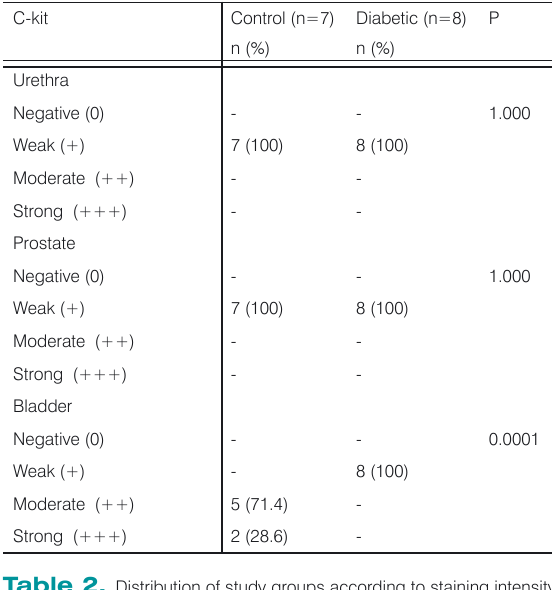
Table 1. Distribution of study groups according to staining intensity regarding c-kit positive interstitial cells present in the lower urinary tract of rabbits.